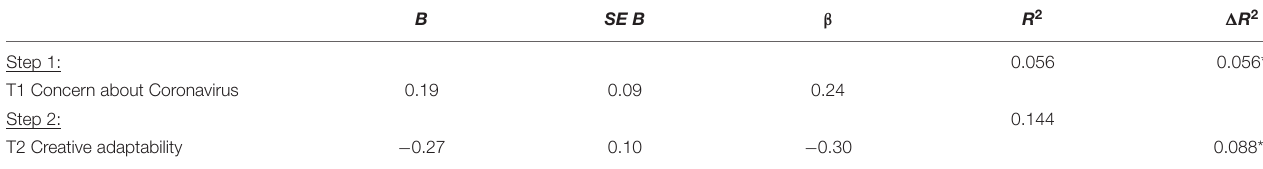
TABLE 6 | Study 2 hierarchical regression analysis summary for creative adaptability predicting psychological